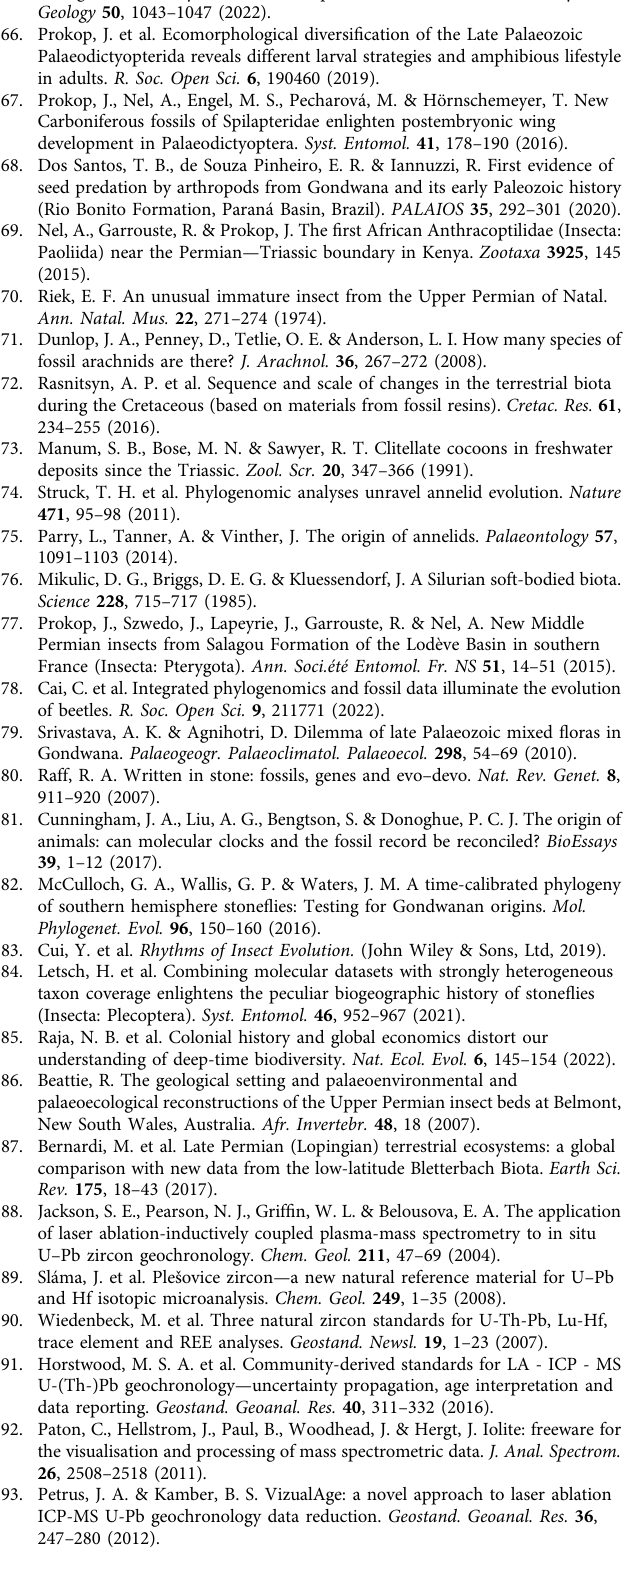
Fig. 2 M.O.D.; Fig. 3, Supplementary Fig. 2